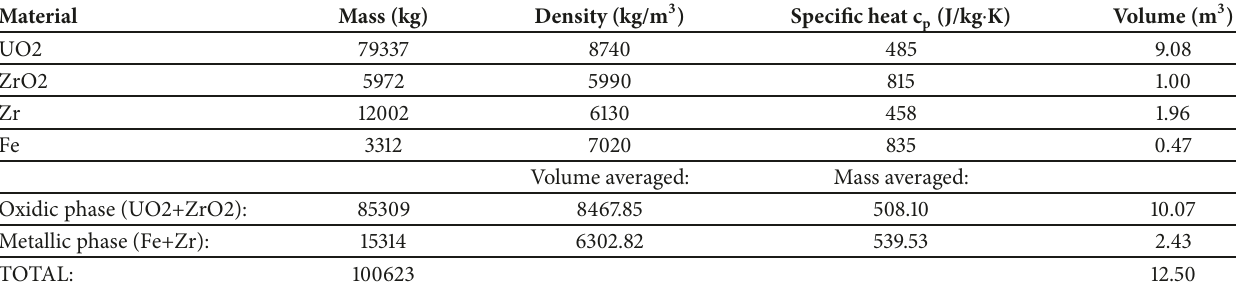
Table 3: Inventories and basic properties of relocated materials.